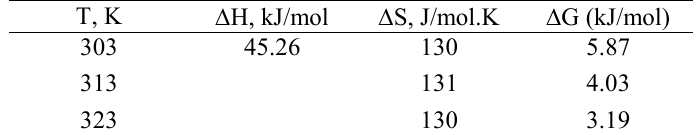
Table 5. The thermodynamic parameters for the adsorption of U(VI) on STH. T, K  H,